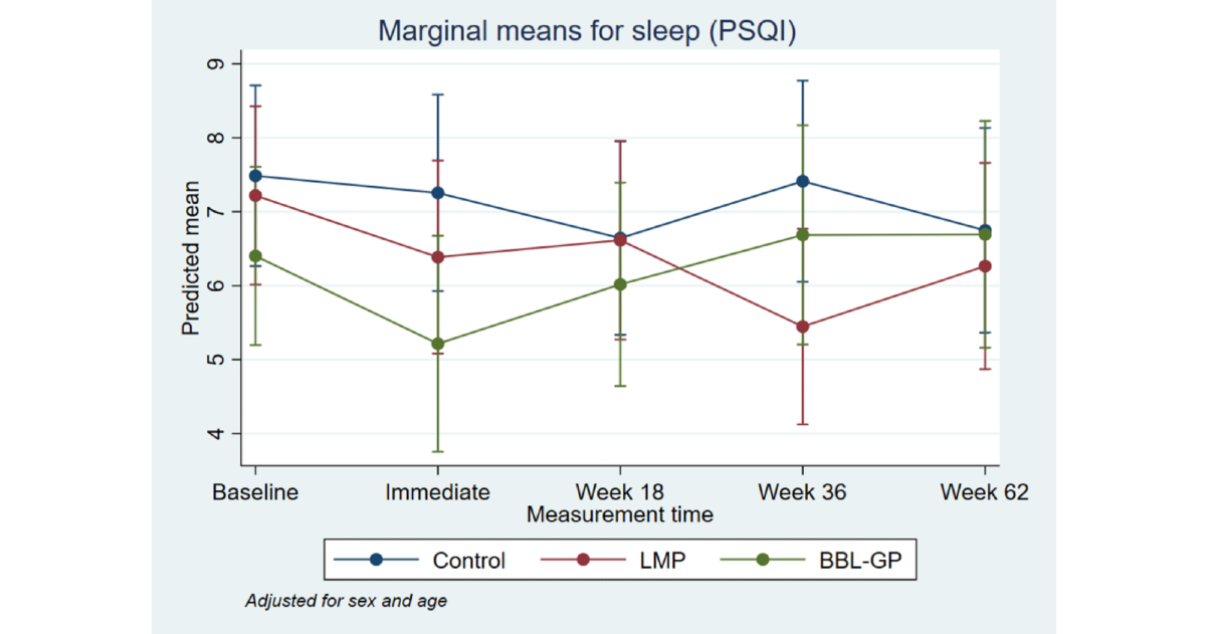
Figure 8. Mean Sleep Score (PSQI) with 95% CI, by time point and intervention group. BBL-GP: Body Brain Life in General Practice; LMP: Lifestyle Modification